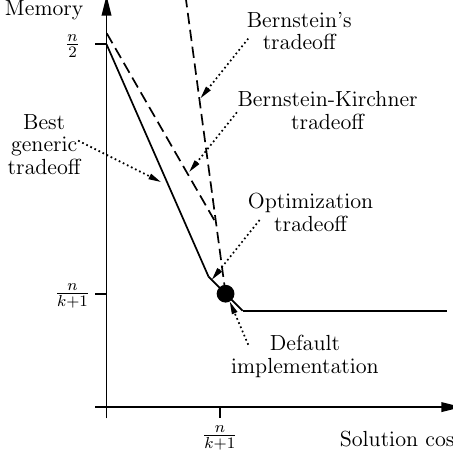
Fig. 4. Computation-memory tradeoffs for the generalized birthday algorithm: ours (Propo- sition 4), Bernstein’s, 22 and “Bernstein-Kirchner”. 23,44 The complexities are given in log